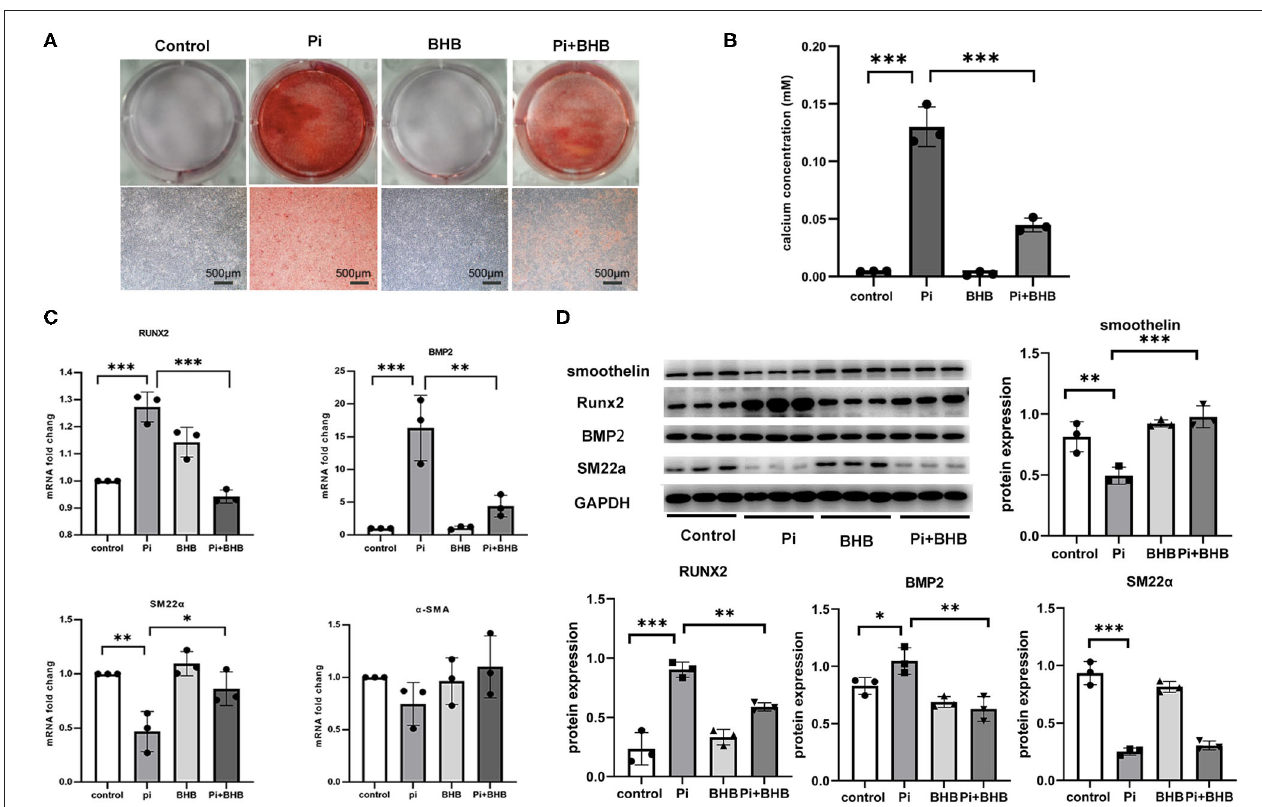
FIGURE 3 | β -Hydroxybutyric acid (BHB) inhibited the osteogenic phenotypical transition of vascular smooth muscle cells (VSMCs). (A) Alizarin Red S staining of VSMCs. Primary VSMCs were treated with Pi (2.6mM), BHB (4.0mM), or Pi (2.6mM) + BHB (4.0mM) for 7 days. Scale bar: 500 µ m. (B) Calcium density analysis examined the calcium concentration in supernatant collected from VSMCs. (C) qPCR detected the differences in the transcription levels of Runx2, BMP2, SM22 α , and α -SMA. (D) Representative Western blot bands and semi-quantitative analysis of the protein expression of smoothelin, Runx2, BMP2, and SM22a. * P < 0.05; ** P < 0.01; *** P <